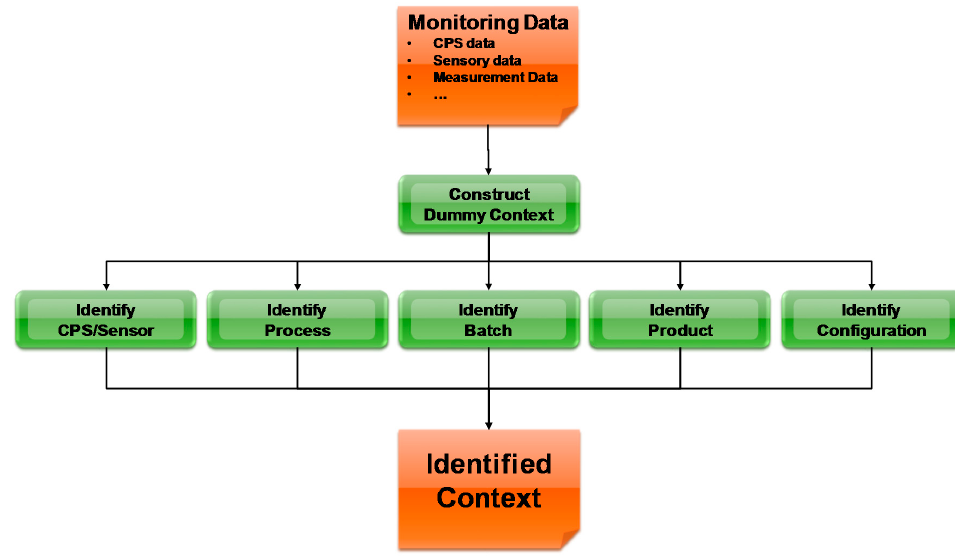
Figure 6. The Process of Context Identification.